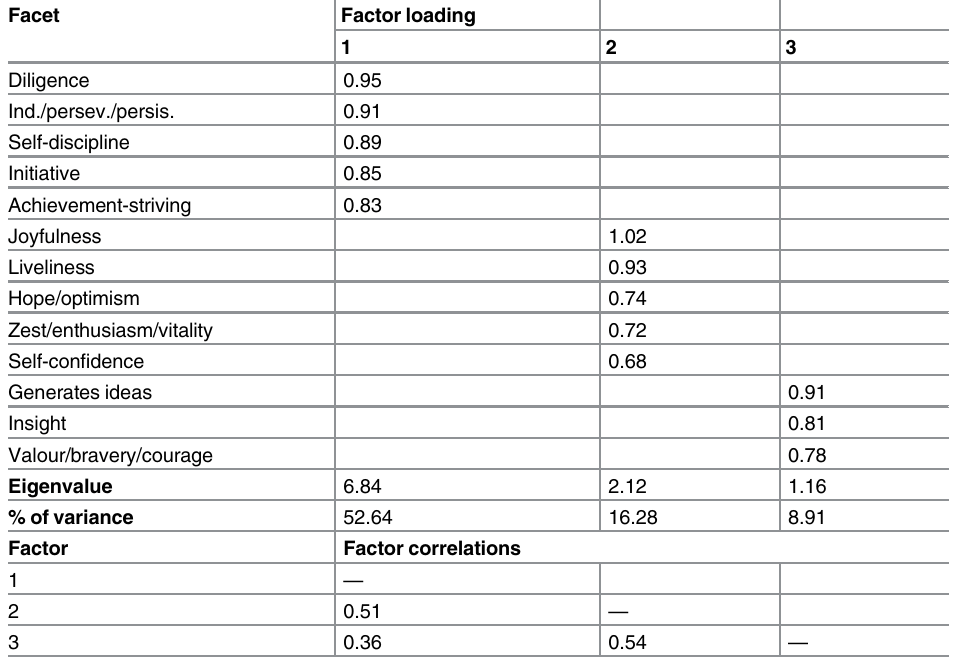
N = 241. Factor loadings of < .30 are omitted from the table. IPIP = International Personality Item Pool; Ind./ persev./persis. =